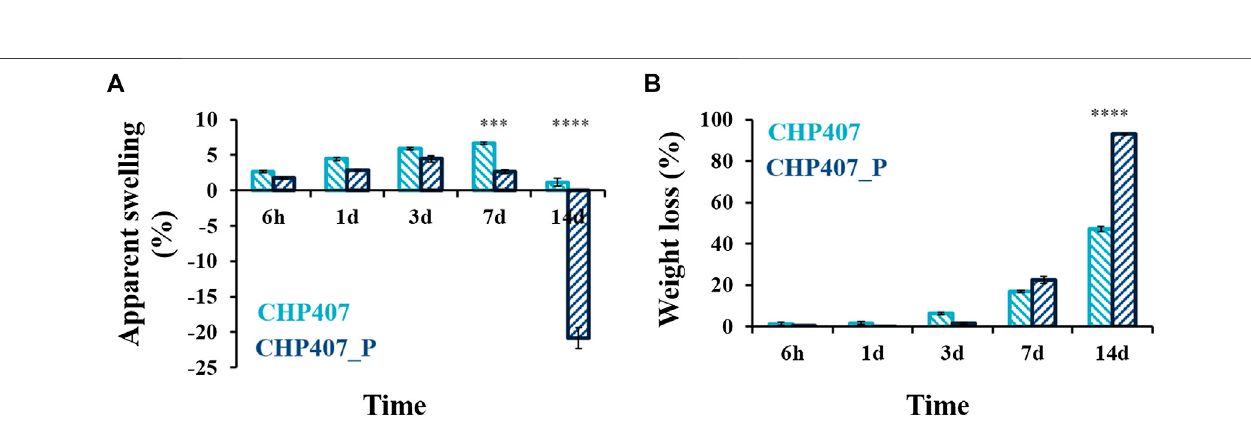
FIGURE 10 | Apparent swelling (A) and weight loss (B) percentages measured for CHP407 (light blue) and CHP407_P (dark blue) samples upon incubation in Trizma ® buffer at 37 ° C for 6 h, 1, 3, 7, and 14 days. Data were reported as average values ± standard deviation.